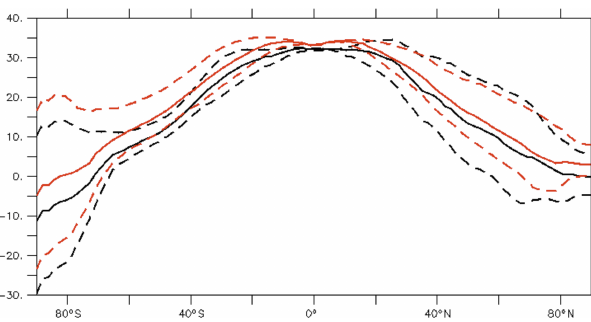
Figure 6. T2M ( ◦ C) mean annual meridional gradients for 4X- NI-PFT-SOIL-SOLAR (black) and 4X-CRETACEOUS (red) sim- ulations. Solid curve corresponds to annual average; dashed curves correspond to winter and summer values. The 4X-CRETACEOUS simulation is generally warmer than the 4X-NI-PFT-SOIL-SOLAR- SOLAR simulation, with the exception of the boreal